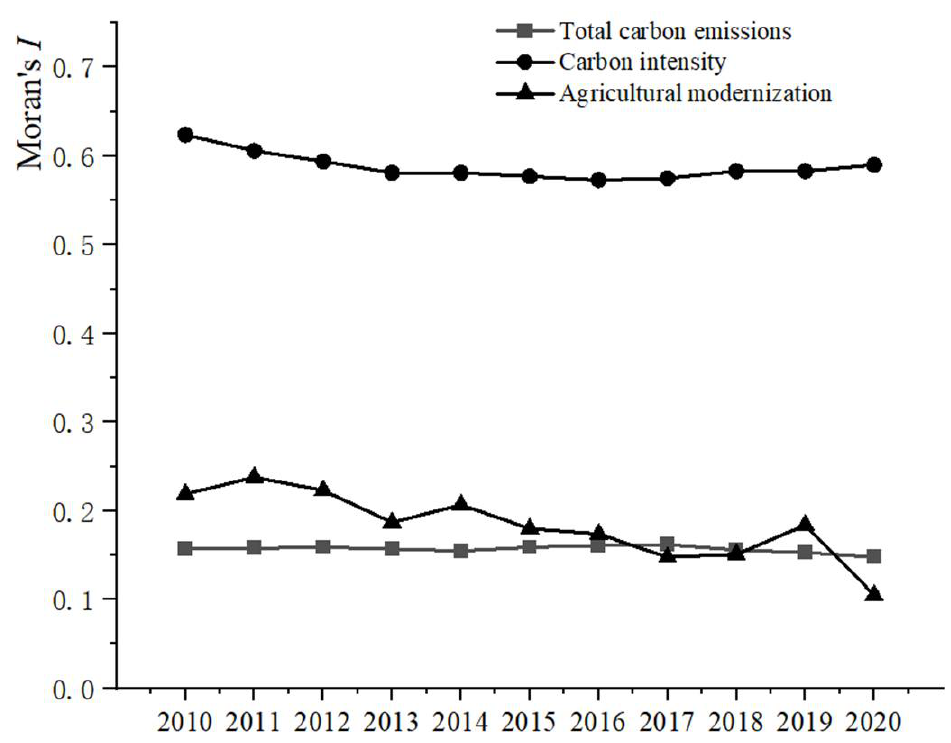
Figure 5. Global Moran’s I of agricultural carbon emission and modern agricultural levels.